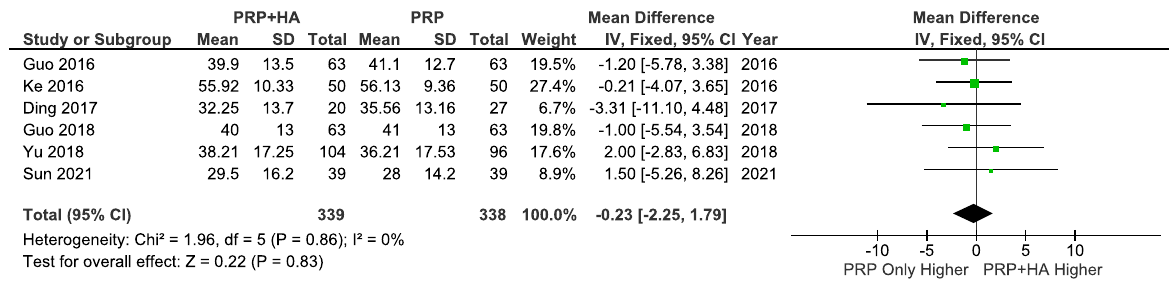
Fig. 10 Showing the Forest plot comparing the WOMAC function scores between PRP